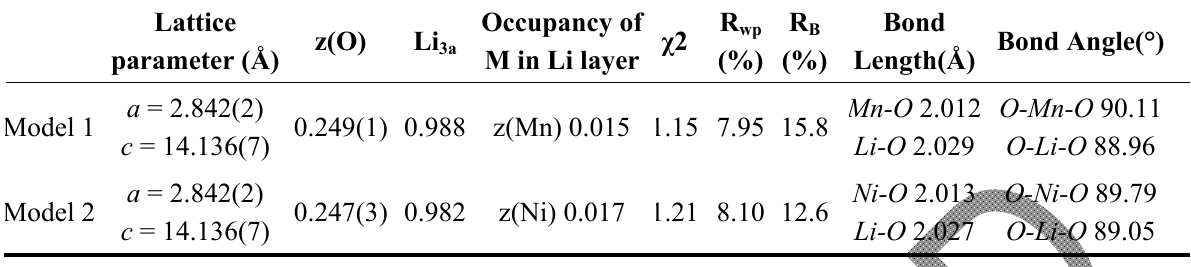
Table 2. Rietveld refinement results of composition #6.